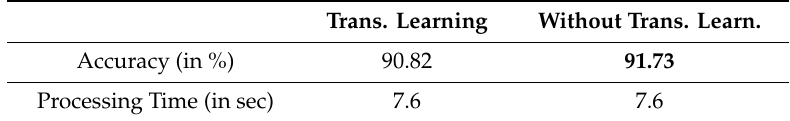
Table 6. Accuracies and processing time (in sec) obtained with and without applying transfer learning on the Solar Panel dataset.